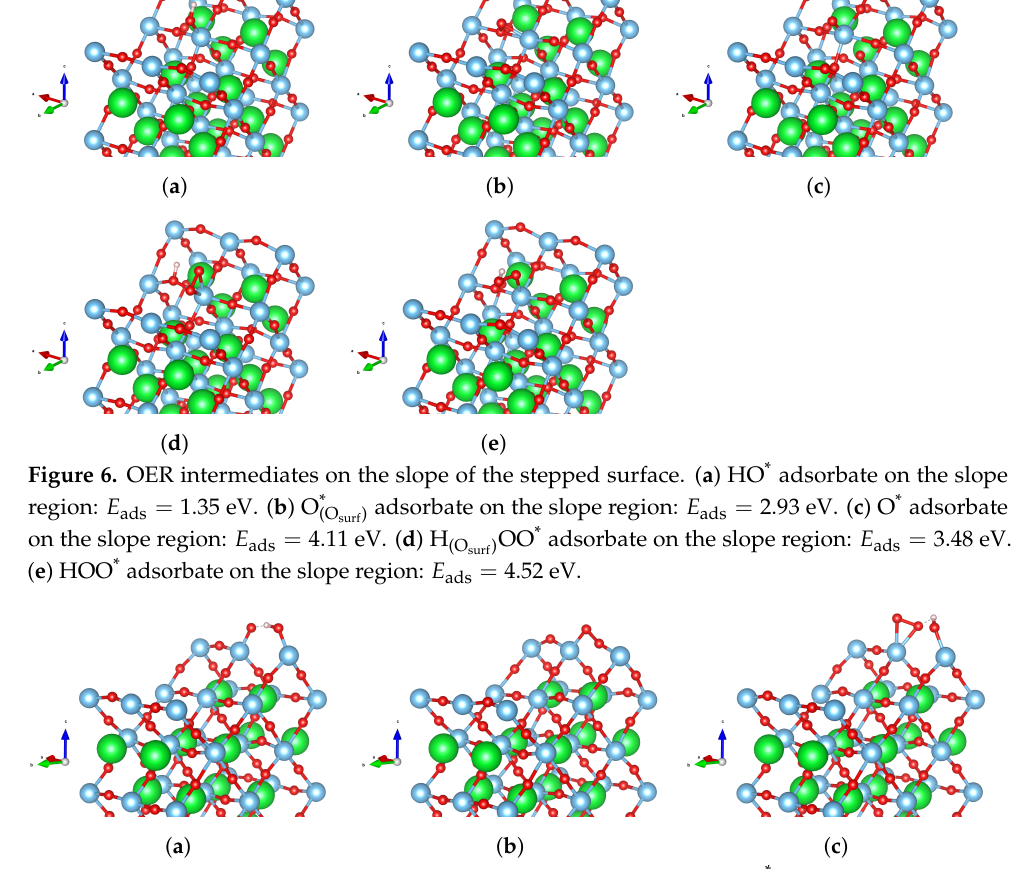
Figure 7. OER intermediates on the ridge of the stepped surface. ( a ) HO * adsorbate on the ridge region: E ads = 1.24 eV. ( b ) O * adsorbate on the ridge region: E ads = 2.40 eV. ( c ) HOO * adsorbate on the ridge region: E ads = 3.13